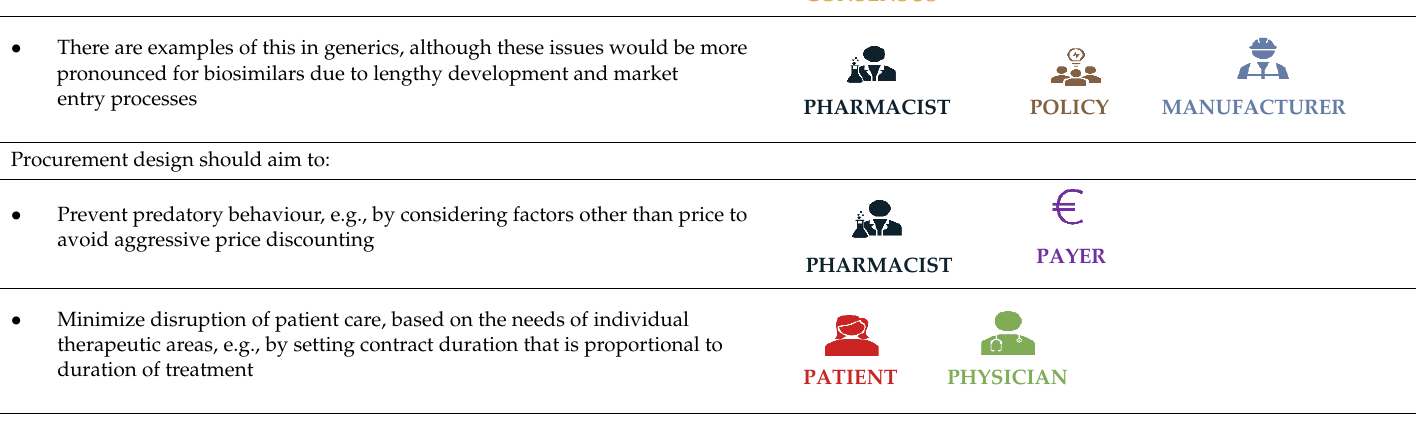
Table 3. Consensus on drivers and risks to biosimilar market sustainability (procurement processes).